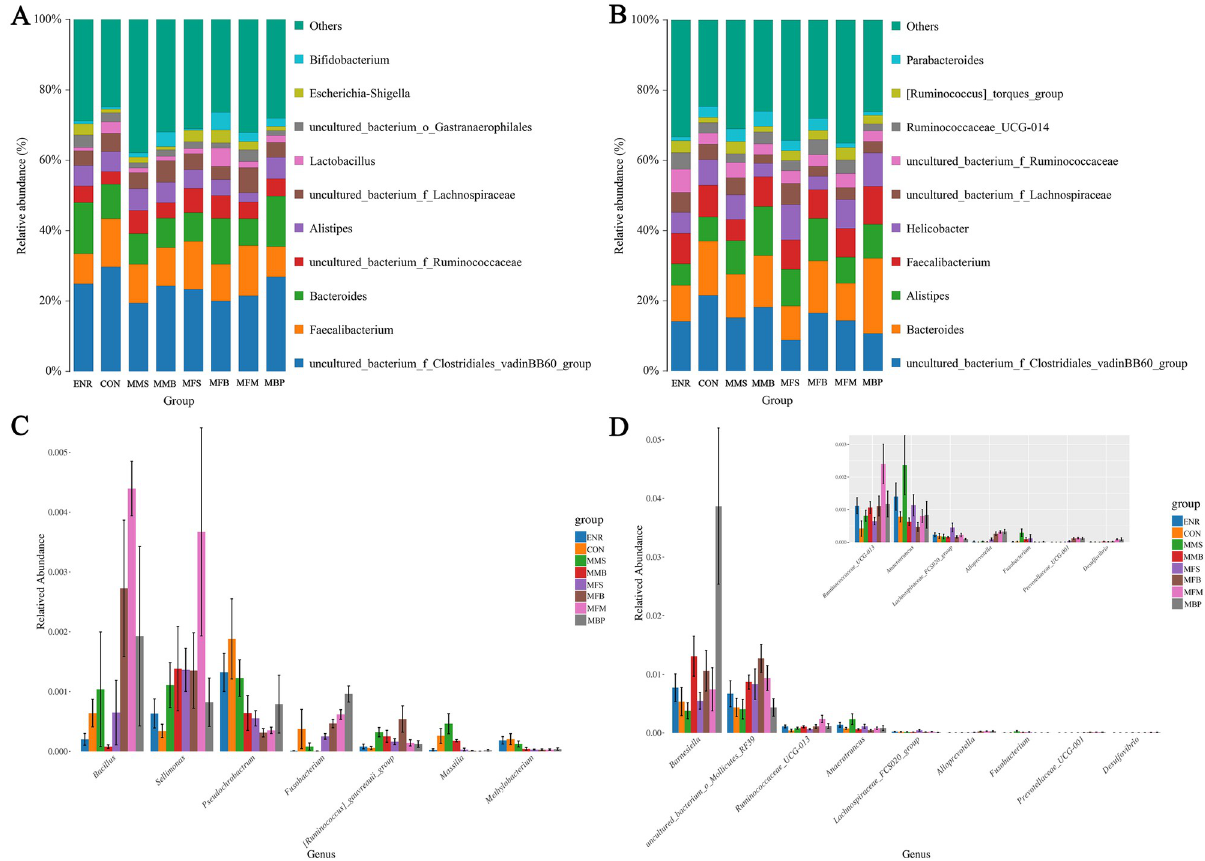
Fig 6. Different taxa and significantly different taxa between different groups by Anova analysis at the genus level at 21 and 42 days old. (A) and (C) 21d. (B) and (D) 42d. CON, control diet; ENR; CON + 100 mg/kg ENR, MMS; CON + 2000 mg/kg MOS + 300 mg/kg MAN + 1500 mg/kg SB, MMB; CON + 2000 mg/kg MOS + 300 mg/kg MAN + 500 mg/kg BS, MFS; CON + 2000 mg/kg MOS + 9000 mg/kg FOS + 1500 mg/kg SB, MFB; CON + 2000 mg/kg MOS + 9000 mg/kg FOS + 500 mg/kg BS, MFM; CON + 2000 mg/kg MOS + 9000 mg/kg FOS + 300 mg/kg MAN, MBP; CON + 2000 mg/kg MOS + 500 mg/kg BS + 37 mg/kg PT. SB; Sodium butyrate, FOS; Fructose oligosaccharide, PT; Phytase, BS; Bacillus subtilis, MOS; Mannose oligosaccharide, MAN;